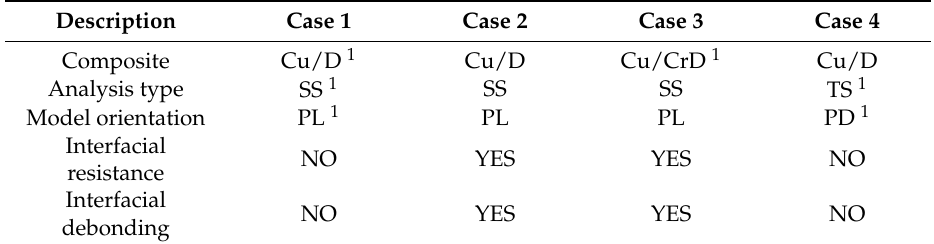
Figure 1. Schematic of the heat sink indicating the heat flow from source to ambient, such that T source > T amb , in the perpendicular and parallel orientations. Table 1. Types of thermo-mechanical analyses.